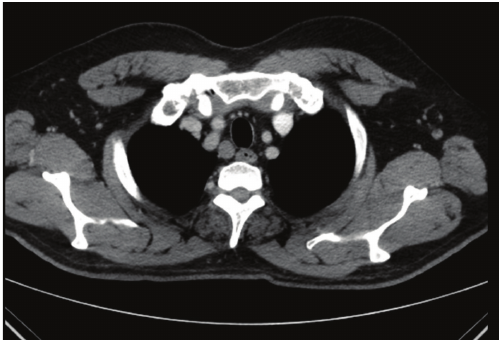
Figure 3: Right Paratracheal lymphadenopathy.